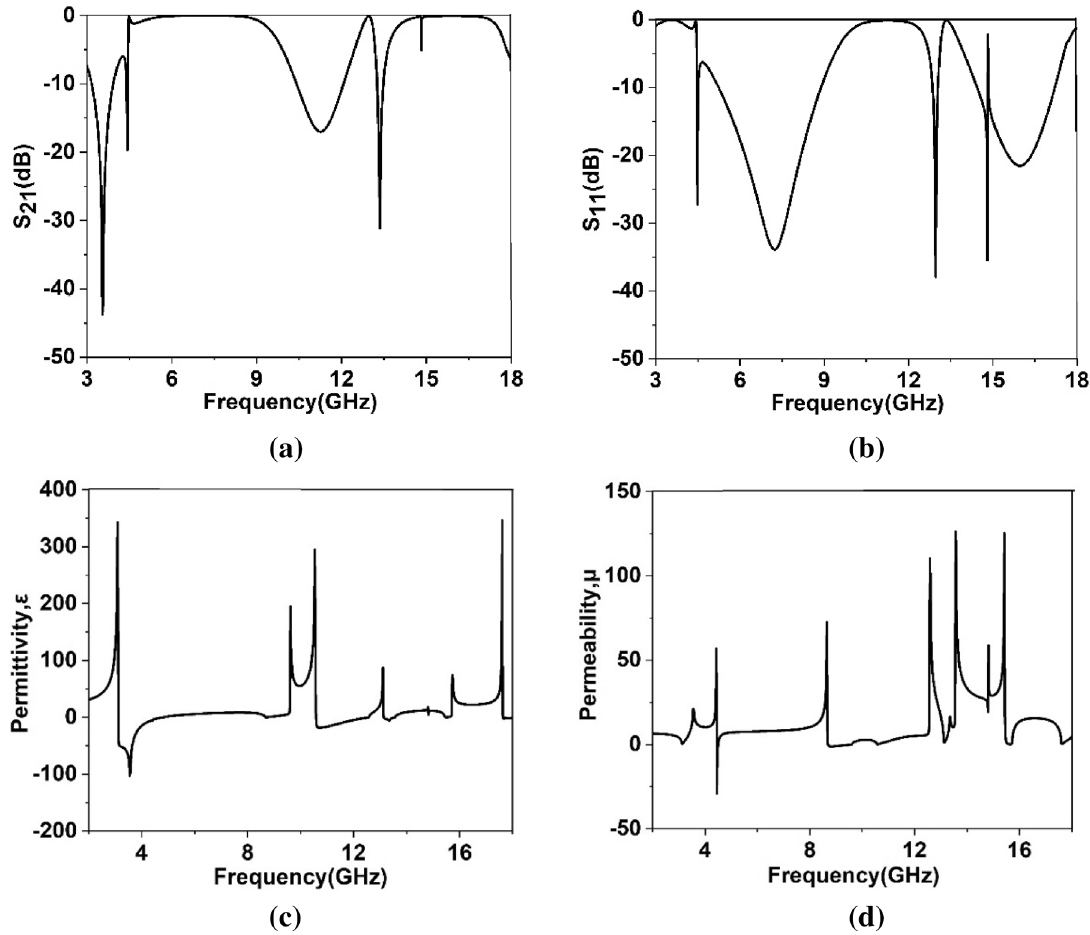
Figure 14. ( a ) Transmisson coefficient (S 21 ) ( b ) reflection coefficien (S 11 ) ( c ) permittivity ( d ) permeability where ports are assigned in X